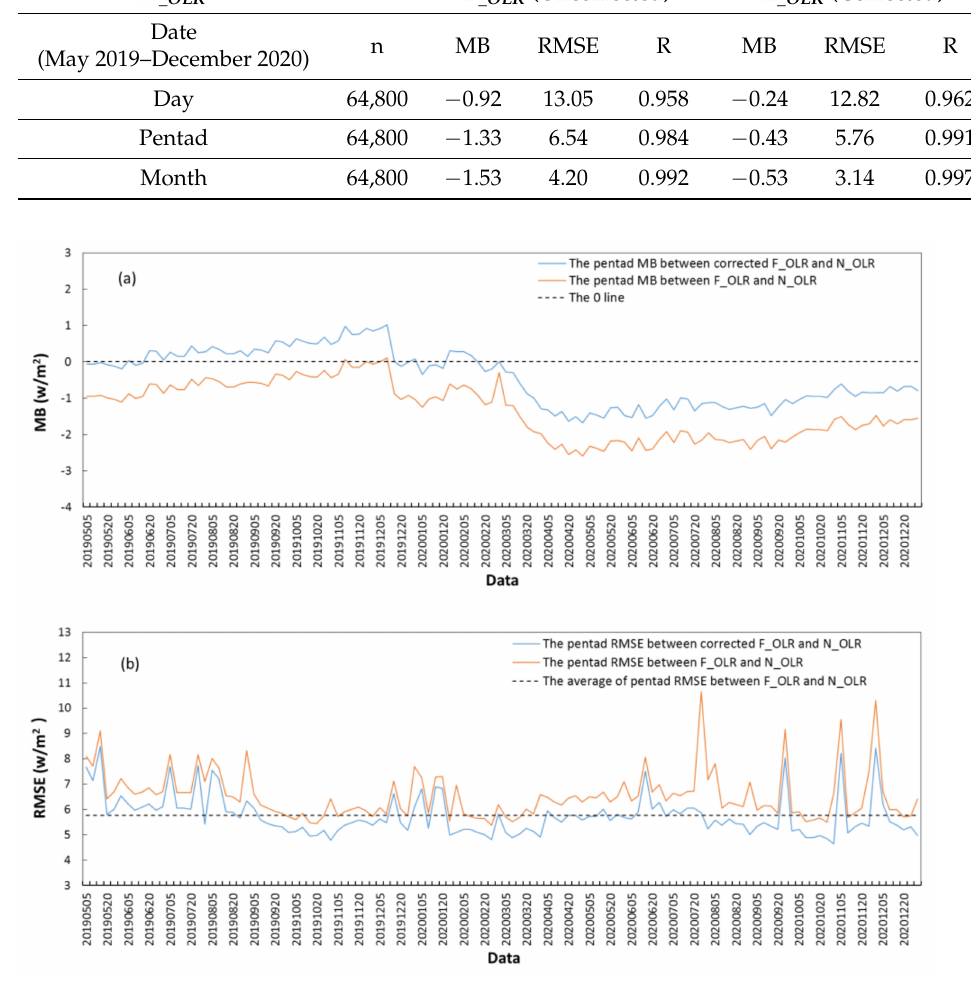
Figure 4. Variations in the global pentad average of ( a ) the MB and ( b ) the RMSE between F _OLR and N _OLR and between the corrected F _OLR and N _OLR